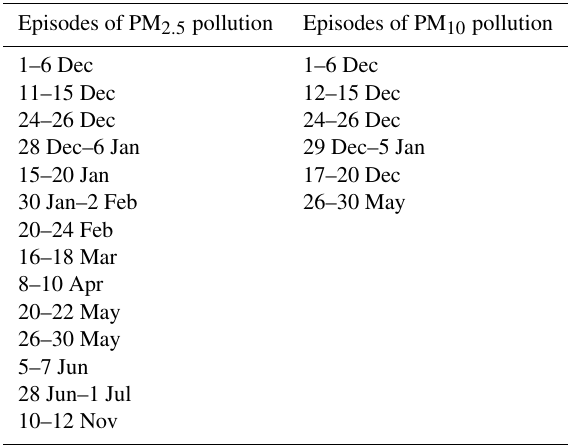
Table 2. The typical regional severe particle pollution episodes (lasting for no less than 3 days) in the YRD from December 2013 to November